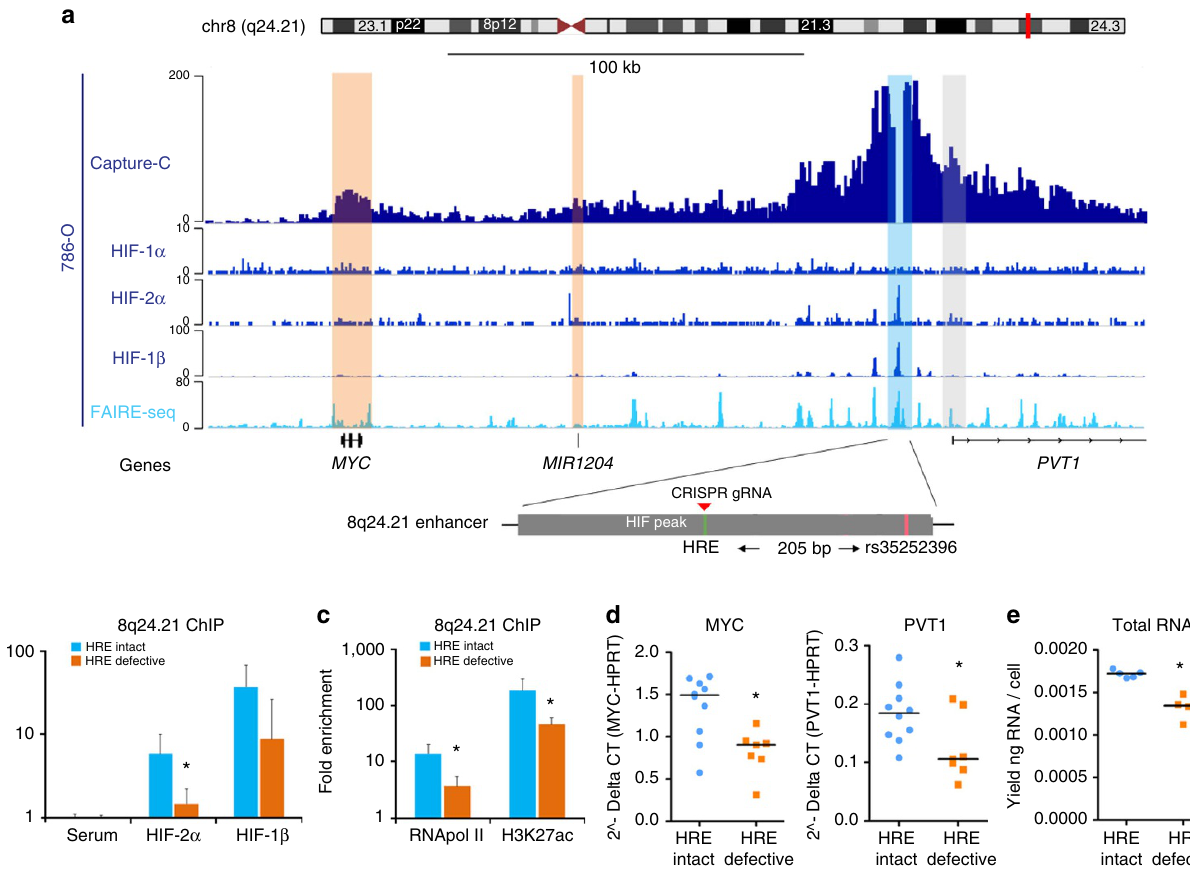
Figure 3 | Functional analysis of the RCC associated 8q24.21 enhancer. ( a ) Capture-C assay reveals chromatin interactions between the 8q24.21 enhancer (anchor site, highlighted in light blue) and the MYC promoter (significant interactions highlighted in light orange) in 786-O cells. Interactions were also observed with the PVT1 promoter, but did not reach statistical significance (highlighted in grey). HIF ChIP-seq shows HIF-1 b and HIF-2 a binding in 786-O cells that lack functional HIF-1 a . Positions of the central HRE, the associated SNP rs35252396 (205bp downstream of the HRE) and the guide RNA used in CRISPR/Cas9 experiments are shown below the tracks. ( b ) HIF ChIP–qPCR confirmed reduced binding of HIF-2 a (*Student’s t -test, P o 0.05) and HIF-1 b (Student’s t -test, P ¼ 0.09) to the 8q24.21 enhancer in 786-O HRE-defective cells. Data are shown in a log scale and are mean ± s.d. from three independent clones of cells with intact or defective HRE, respectively. ( c ) qPCR using RNApol2 and H3K27ac ChIP samples reveals lower levels of marks of active chromatin at the 8q24.21 enhancer in 786-0 HRE-defective cells. Data are shown in a log scale and are mean ± s.d. from three independent clones of cells with intact or defective HRE. *One-sample t-test, P o 0.05. ( d ) RNA levels of MYC and PVT1 in 786-O cells with defective HRE ( n ¼ 7) or intact HRE ( n ¼ 10). Values represent mean from three independent RNA isolations for each clone. *Student’s t-test, P o 0.05, comparing the two groups of cells. ( e ) Total RNA levels are lower in HRE-defective cells. Each dot represents the mean yield of RNA per cell calculated from two to three independent RNA isolations from 50.000 cells per clone of cells. Values are from four (HRE-defective) or five (HRE-intact) clones of cells. *Student’s t -test, P o